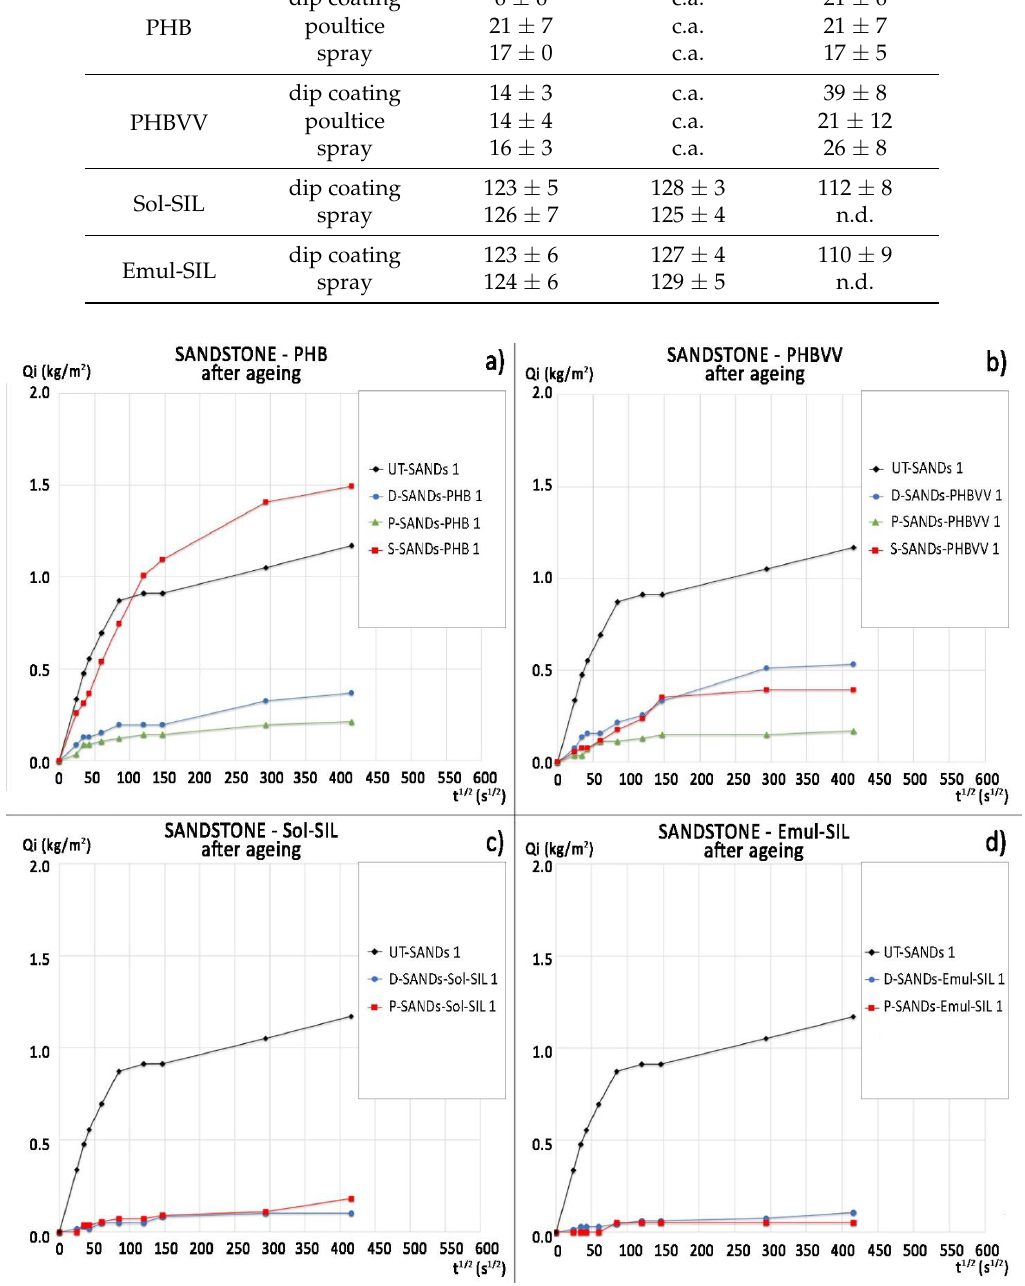
Figure 11. Capillary water absorption curves of sandstone after artificial ageing referred to: ( a ) samples treated with PHB-based formulation; ( b ) samples treated with PHBVV-based formulation; ( c ) samples treated with Sol-SIL; ( d ) samples treated with Emul-SIL.